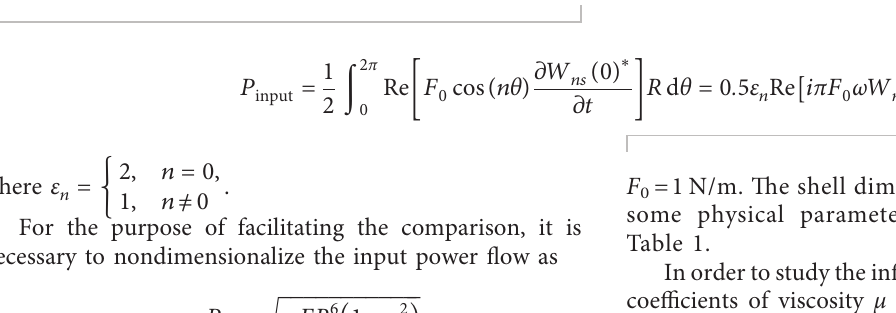
� 1 N/m. The shell dimensions and material as well as F 0 some physical parameters of the fluid are given